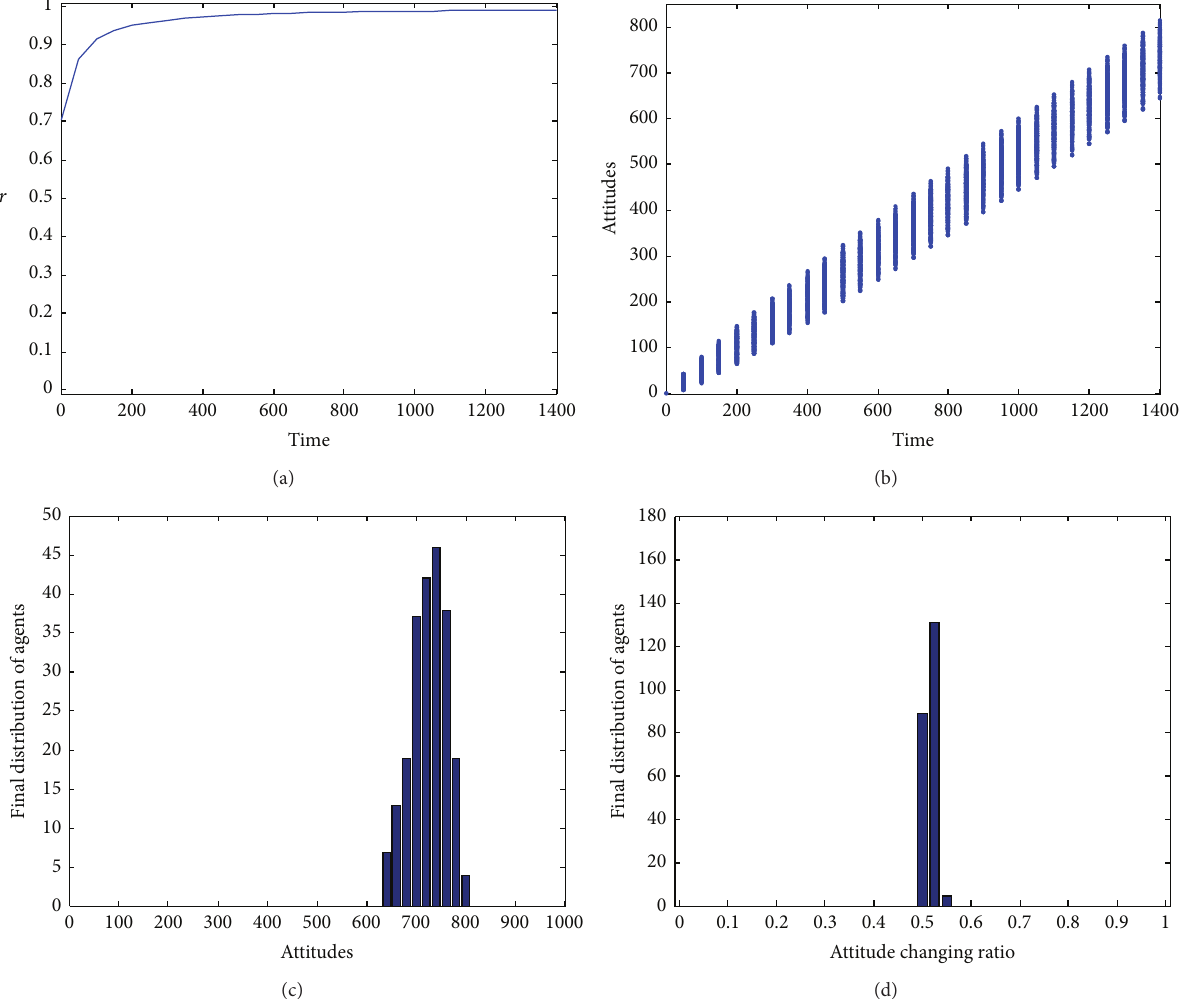
Figure 7: Results of simulation system with 𝐾 = 1 . (a) is the subfigure which shows synchronization criterion 𝑟 changes with time; (b) is the subfigure which shows group attitudes 𝑥(𝑡) versus time; (c) is the histogram of the final distribution of agents versus group attitudes 𝑥(𝑡) ; (d) is the histogram of the final distribution of agents versus attitude changing ratio ̇𝑥 𝑖 (𝑡)